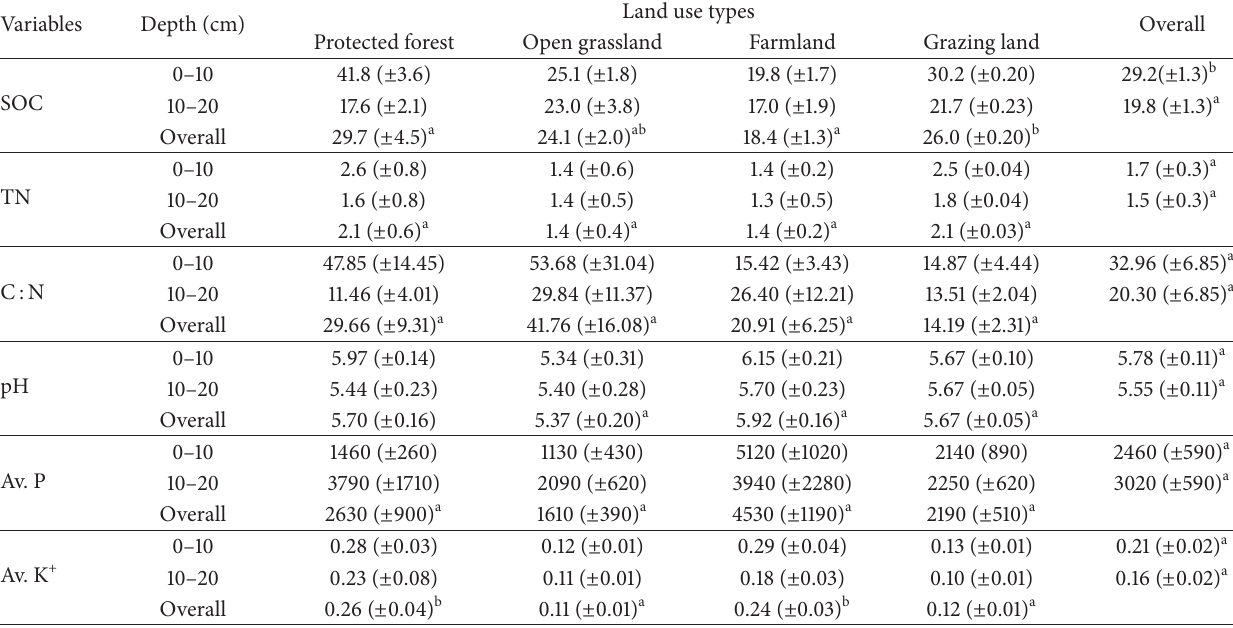
Table 3: SOC (gKg − 1 ), TN (gKg − 1 ), C/N ratio, pH (H (cm) (Mean ±